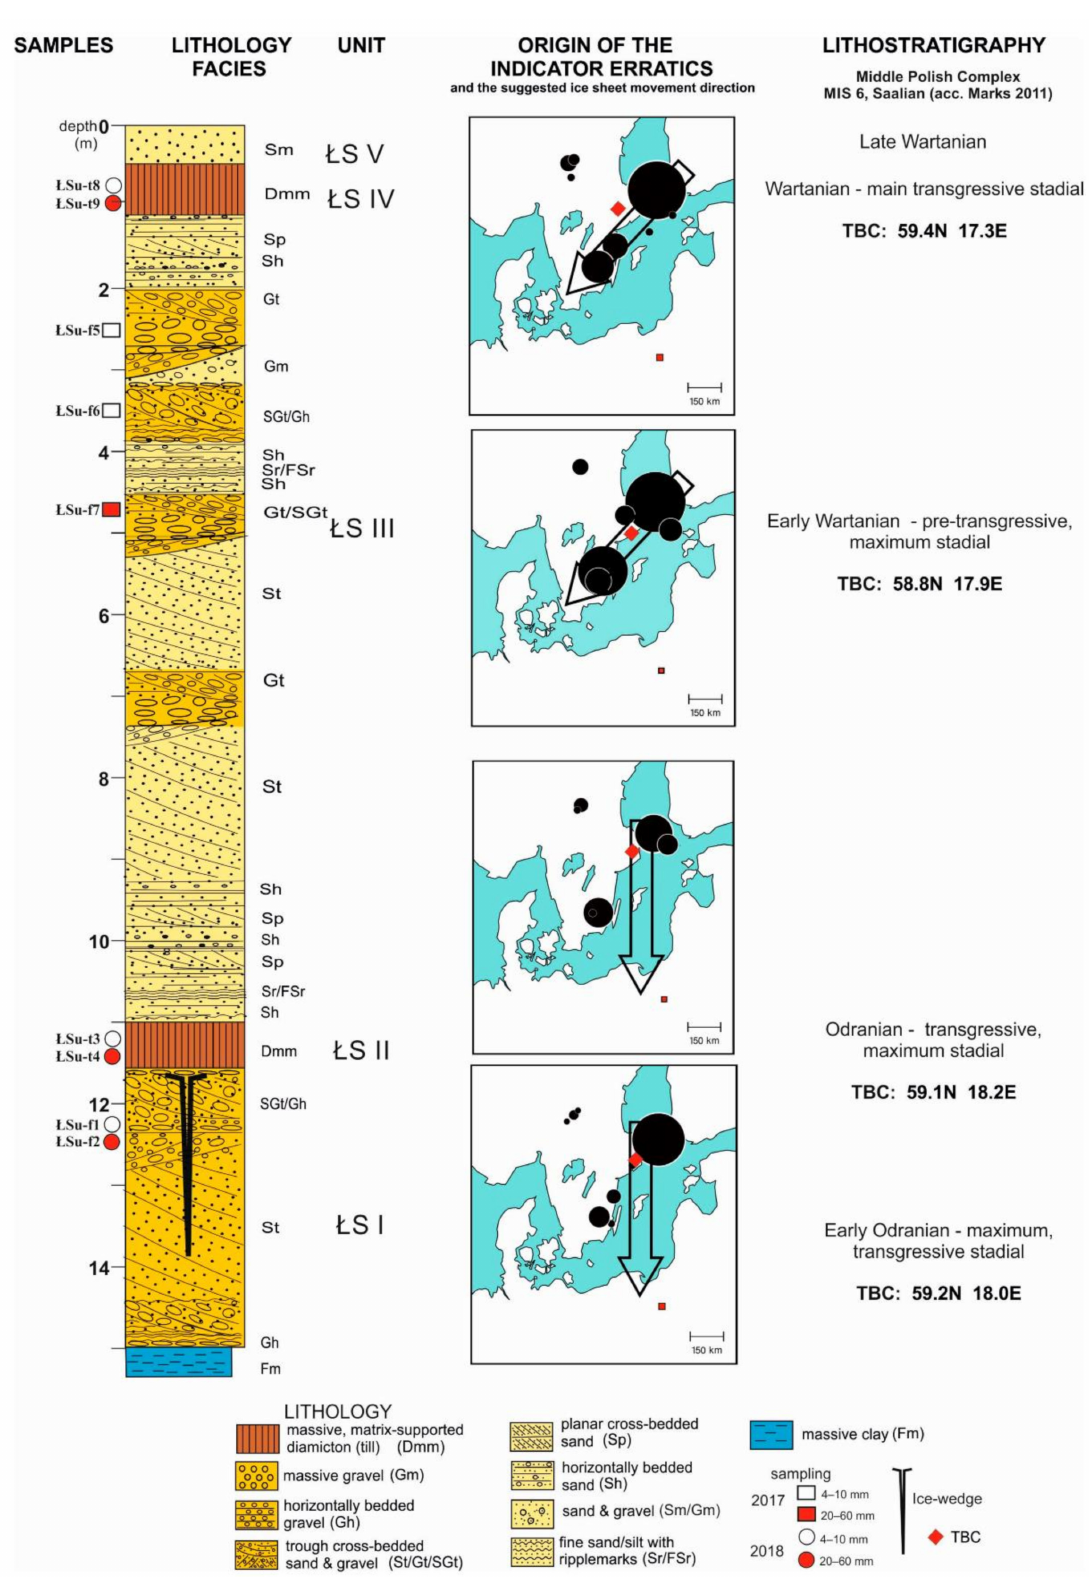
Figure 2. Schematic depth profile of deposits in Łubienica-Superunki with marked sampling sites, origin of indicator erratics and lithostratigraphy according to Marks